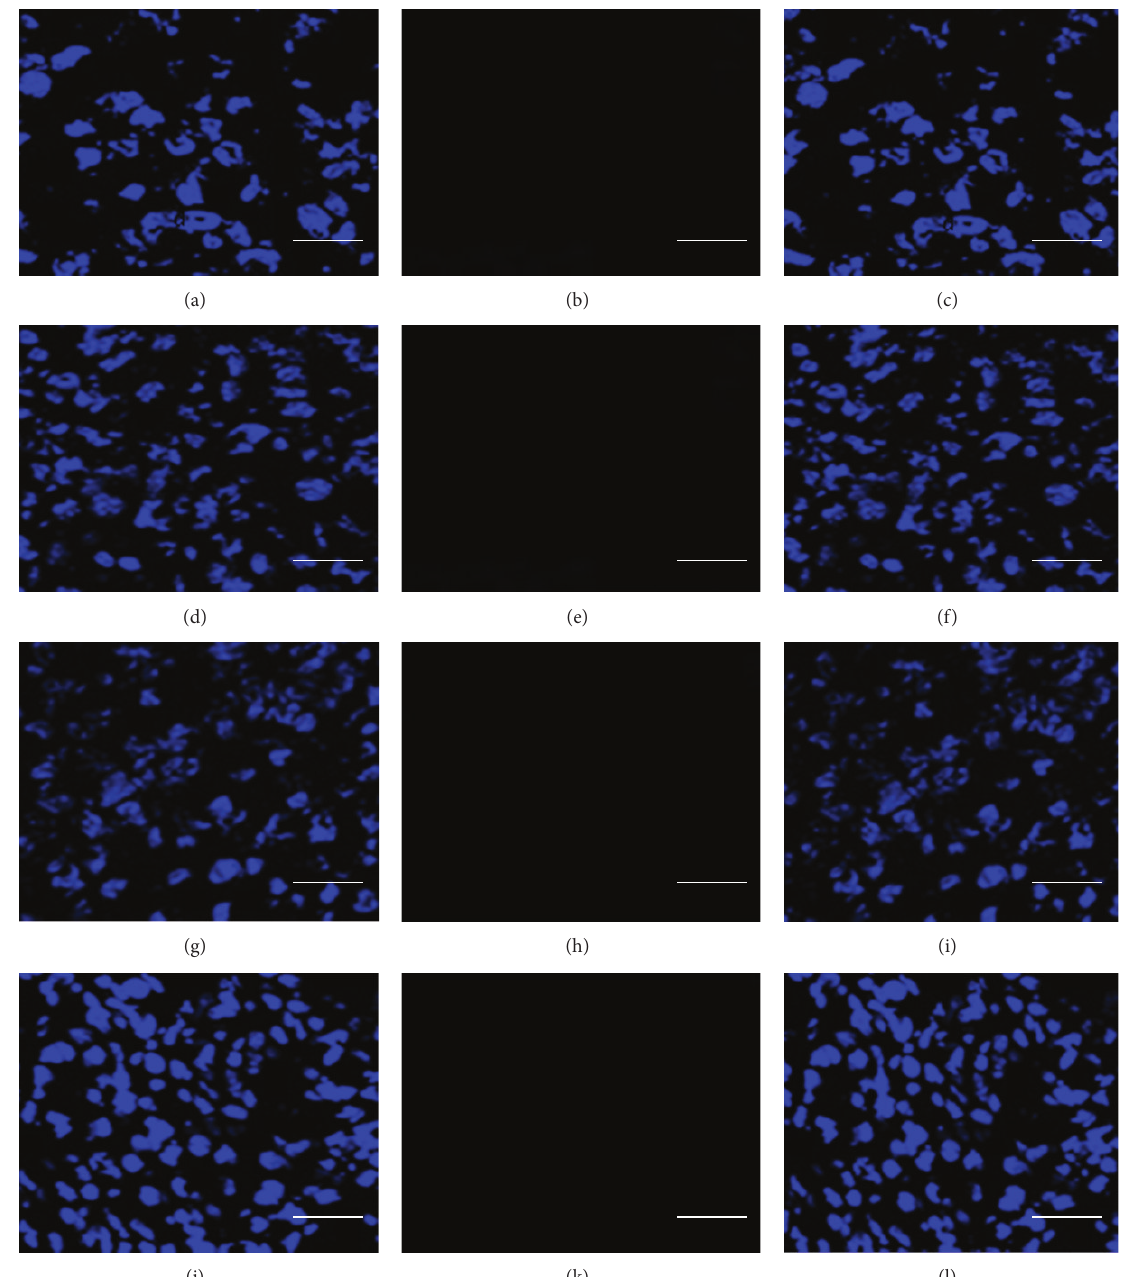
Figure 5: (RGD) 3 -tTF tracing in other tissues. Hoechst 33258-stained nucleus of samples of brain (a), liver (d), kidney (g), and lung (j). No fluorescence was found in samples of brain (b), liver (e), kidney (h), and lung (k). Mergers of (a) and (b) (c), (d) and (e) (f), (g) and (h) (i), and (j) and (k) (l) (bar = 20 𝜇